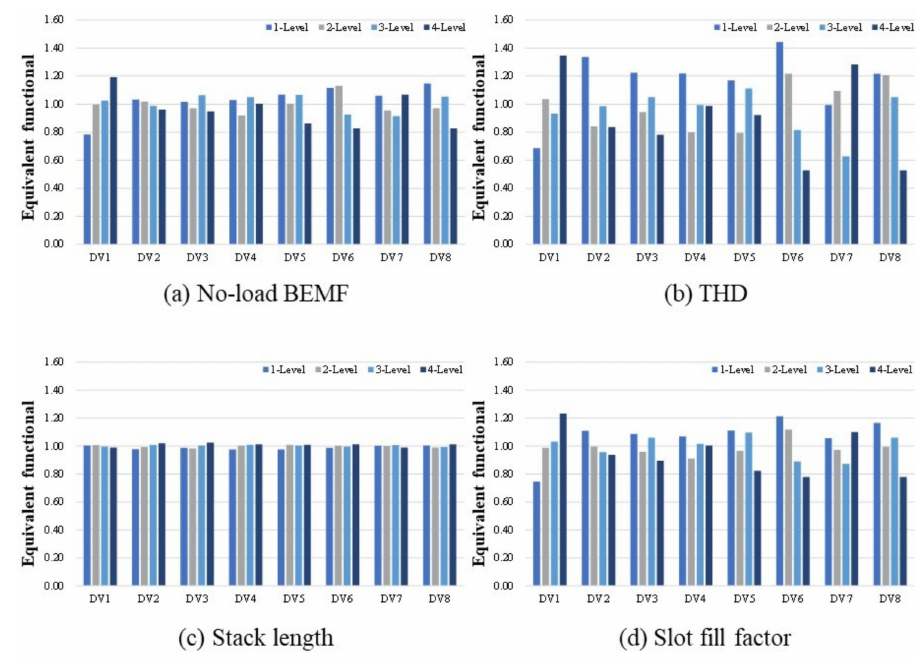
Figure 16. Effect analysis results (20P 18S).